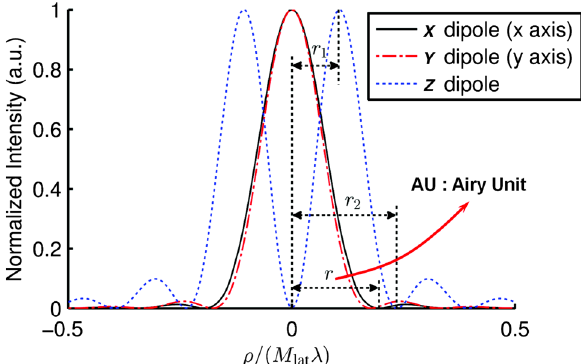
FIG. 5. Point-spread function and candidates for pinhole radii. The cross section of images (point-spread function) of x; y; z dipoles at the focal point are plotted here. x - y plane is the lateral plane and z axis is the longitudinal direction. One Airy unit (AU) given by r (here, r ¼ 25 . 4 μ m) corresponds to the first zero of the point-spread function of x dipole. Dimensions r 1 ¼ 13 . 7 μ m and r ¼ 30 . 6 μ m correspond to the peak and the first zero after the 2 peak of the point-spread function of the z dipole,